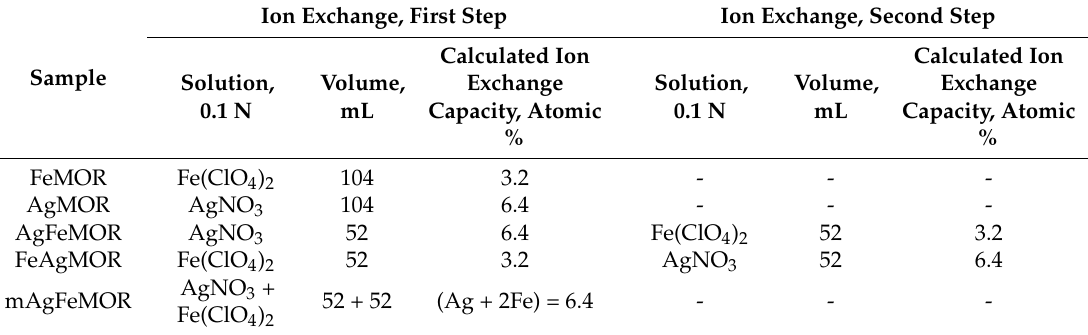
Table 1. Ion-exchange solutions preparation parameters of the exchange while using 3 g of NaMOR for the sample preparation, and the theoretical limit of silver (Ag + ) and iron (Fe 2+ ) content in the samples.